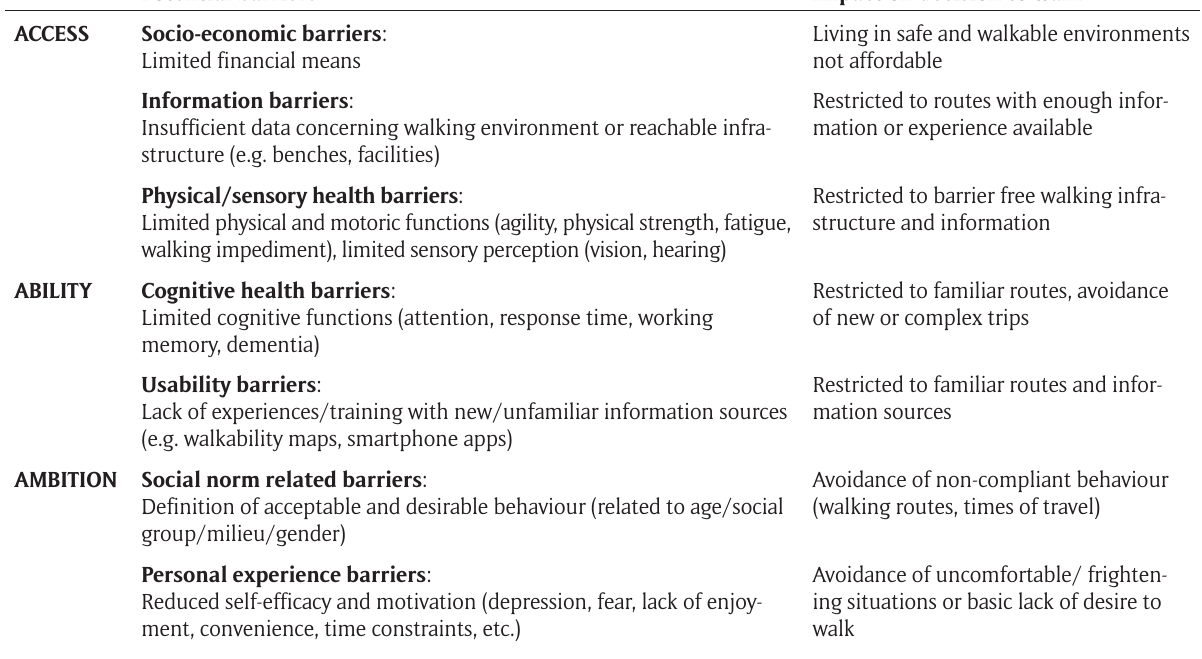
Table 1: Potential barriers affecting access, ability and ambition of walking. Potential